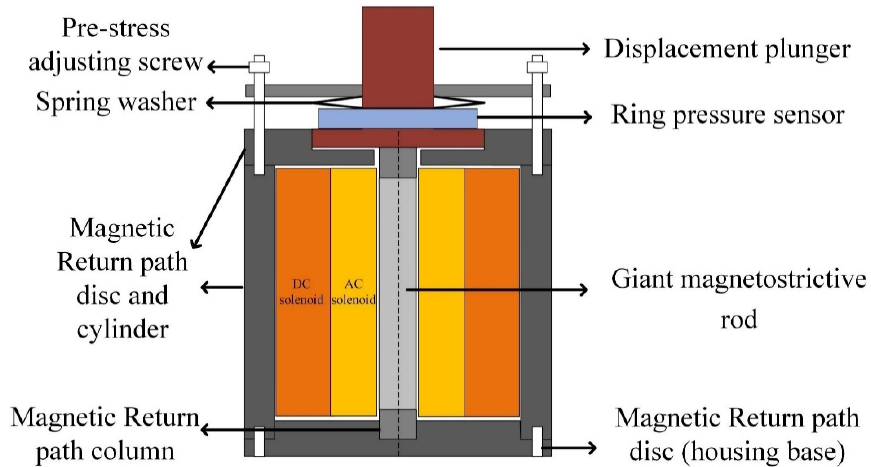
Figure 1. Structural diagram of the longitudinal transducer.